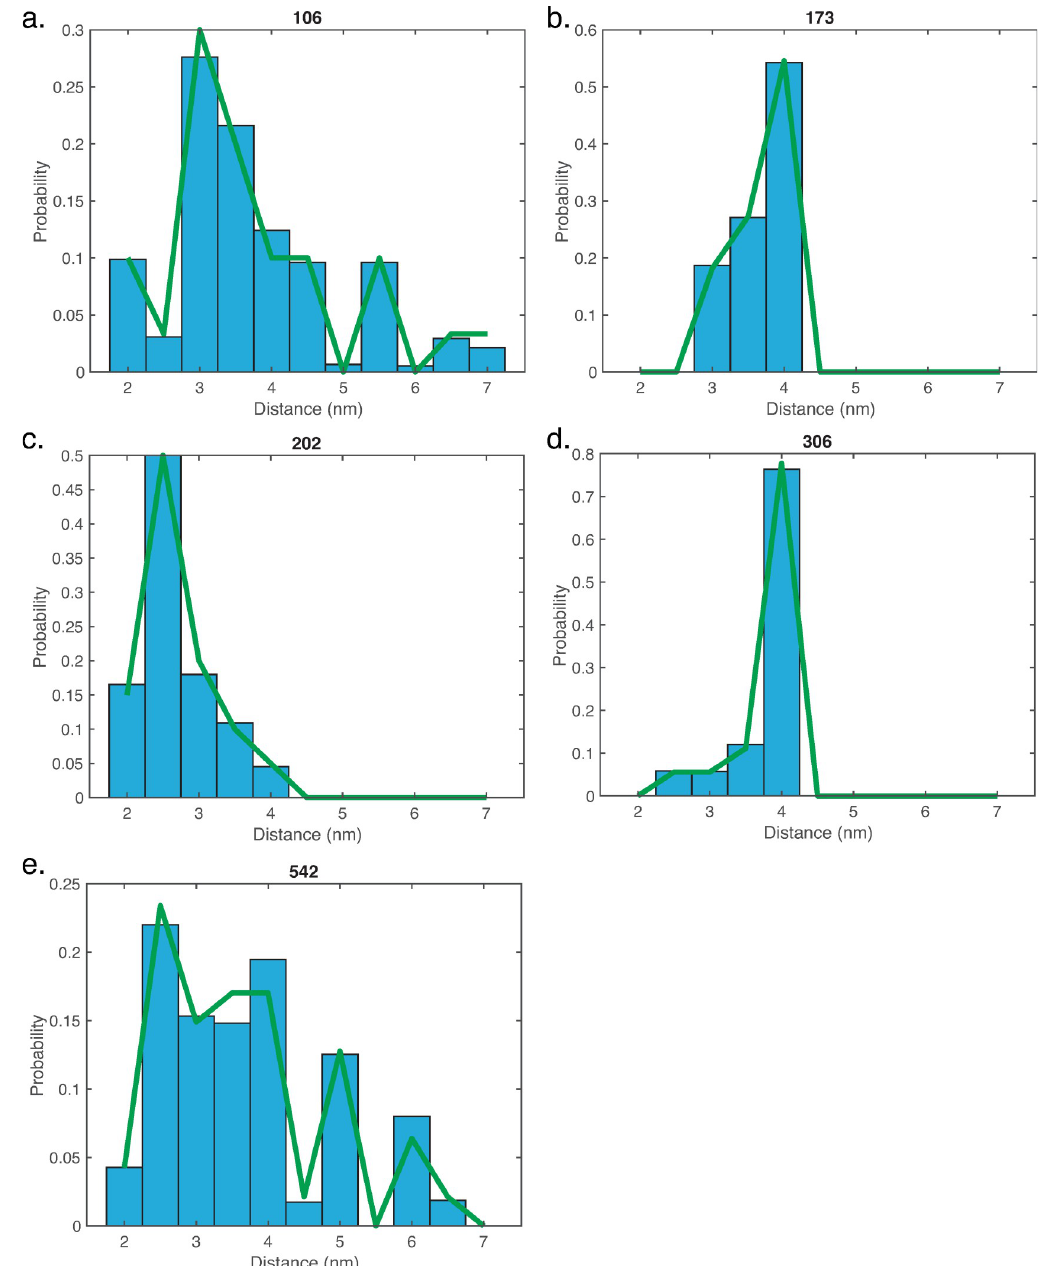
Fig 5. Residue-residue distance distributions in a simulated ensemble of HIV gp41. DEER spectroscopy was used to measure distance distributions between two monomers of the gp41 trimer. Thus, each residue designates a monomer-monomer residue pair. Panels A-E show plots for the 5 restrained residues in the HIV trimer: 106, 173, 202, 306, and 542 respectively. Discretized DEER distance distributions are plotted in green, and simulation results are plotted in blue bars. The simulation ensemble shows good convergence to the measured